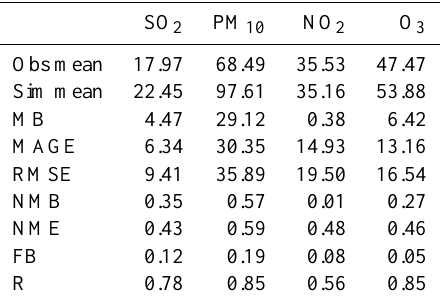
Fig. 3. The scatter plots of SO 2 , PM 10 , NO 2 and O 3 at IAP tower station: three lines indicate y = 0 . 5 x , y = x and y = 2 x . The meteorological tower in IAP tower station has 325m height, the “Layer-2” indicates the air pollutant measurements was setup in 120m height, while the “Layer-3” in 280m height. Table 3. Model evaluation at the Layer-2 of IAP tower (SO 2 , NO 2 and O 3 unit:ppbv; PM 10 unit: µgm − 3 ) 31